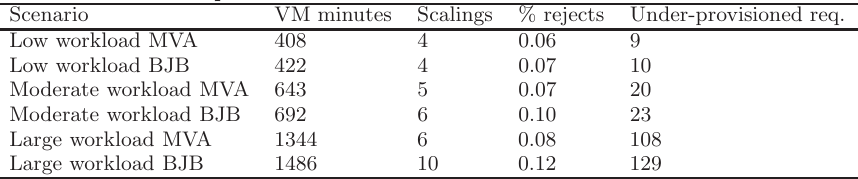
Table 6: Cost and performance results obtained with the RUBiS benchmark